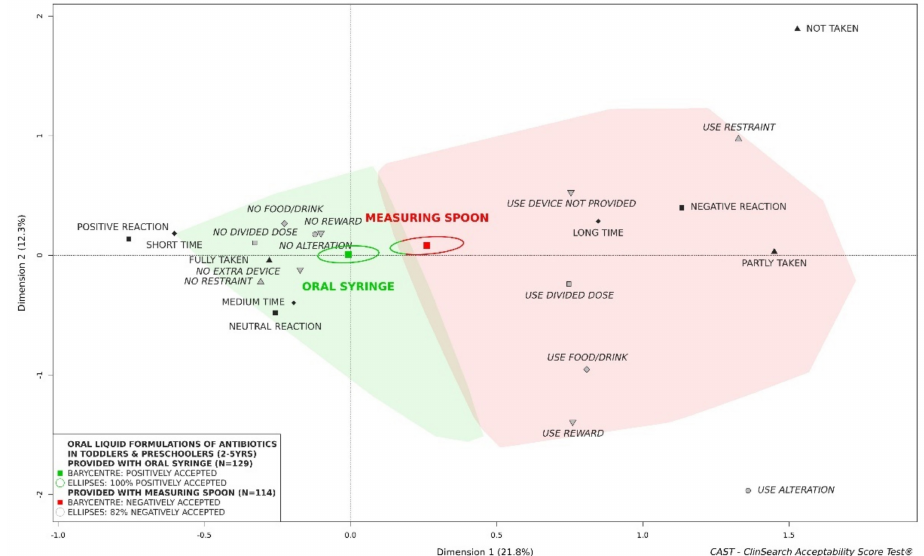
Figure 4. Acceptability of oral liquid formulations of antibiotics in toddlers and preschoolers depend- ing on administration device.